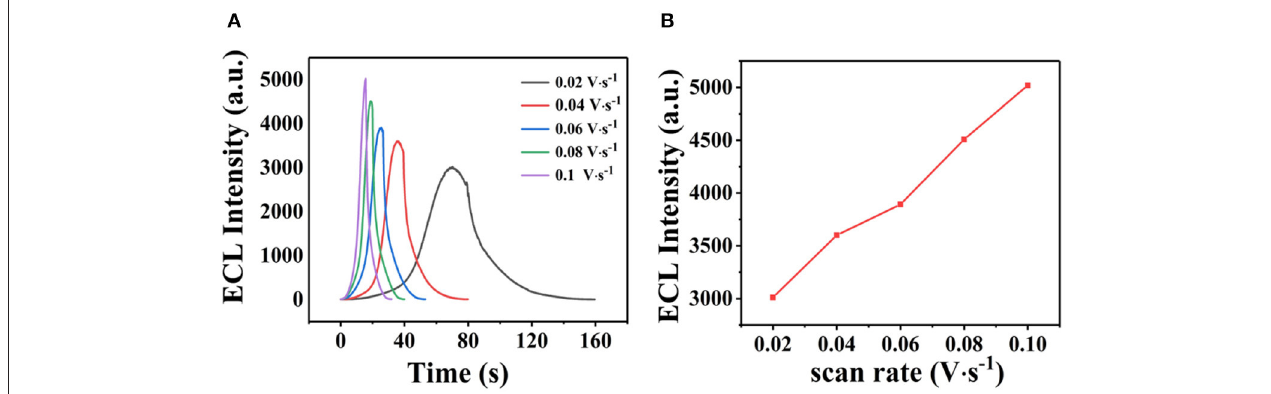
FIGURE 6 | (A) Effect of scan rate on the ECL performance and (B) ECL intensity as a function of scan rate.